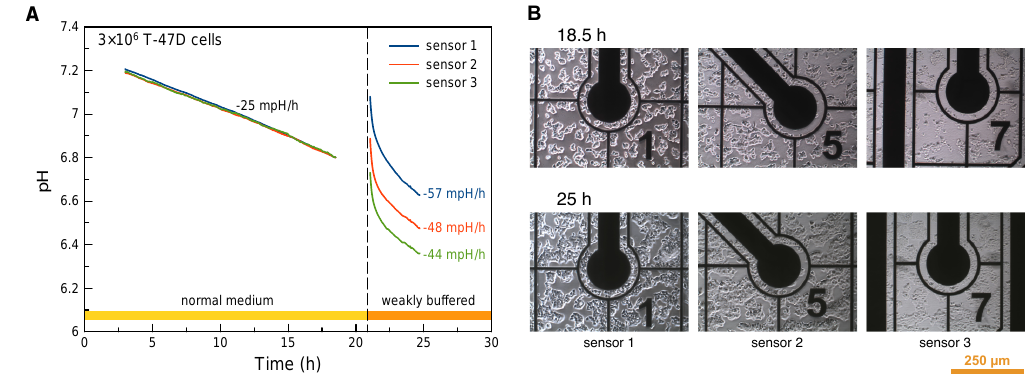
Figure 6. pH monitoring in high density cell culture: Sensor readings ( A ) from cells cultured in normal and weakly buffered medium; The cell images ( B ) were taken close to the three different pH sensor